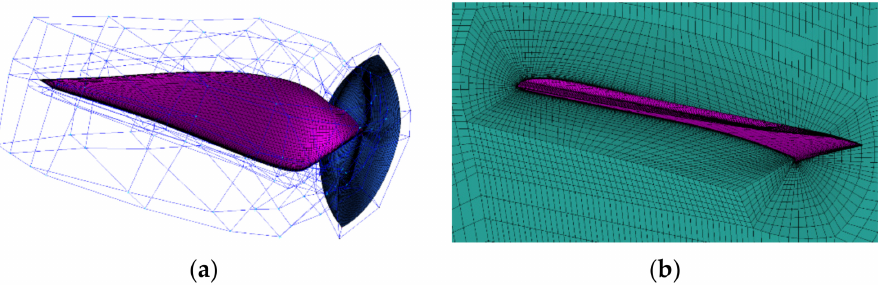
Figure 13. Computation grid of the propeller with a Gurney flap: ( a ) Adjustable blocks around the propeller; ( b ) Grid around cross-sectional airfoil with a Gurney